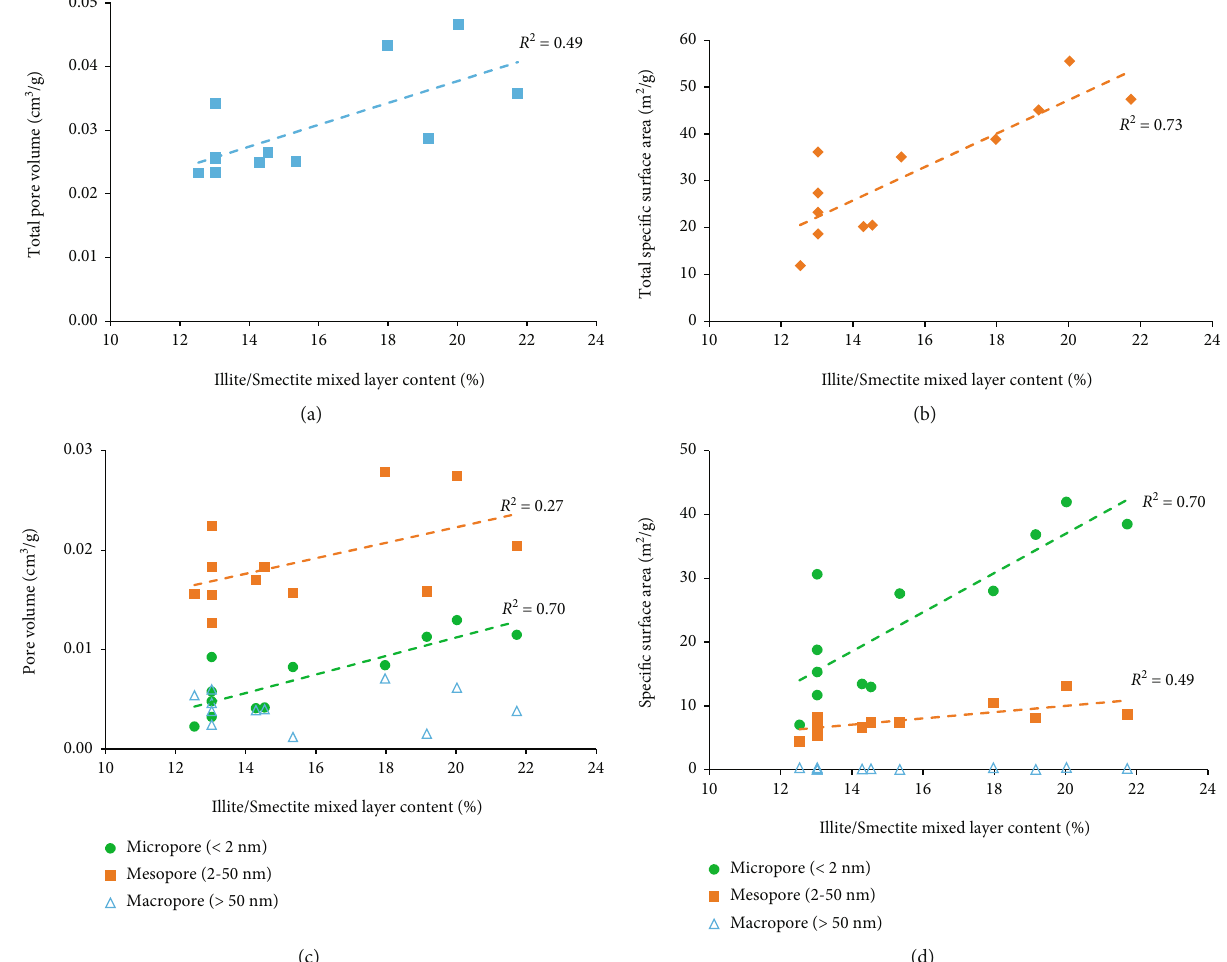
Figure 11: Cross-plots of illite/smectite mixed layer content with (a) total PV, (b) total SSA, (c) PV, and (d)